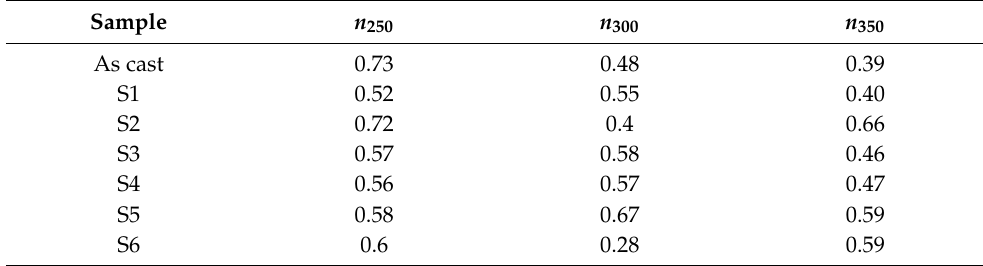
Table 4. Avrami exponent of the JMA model during hydrogenation of different samples at various temperatures.